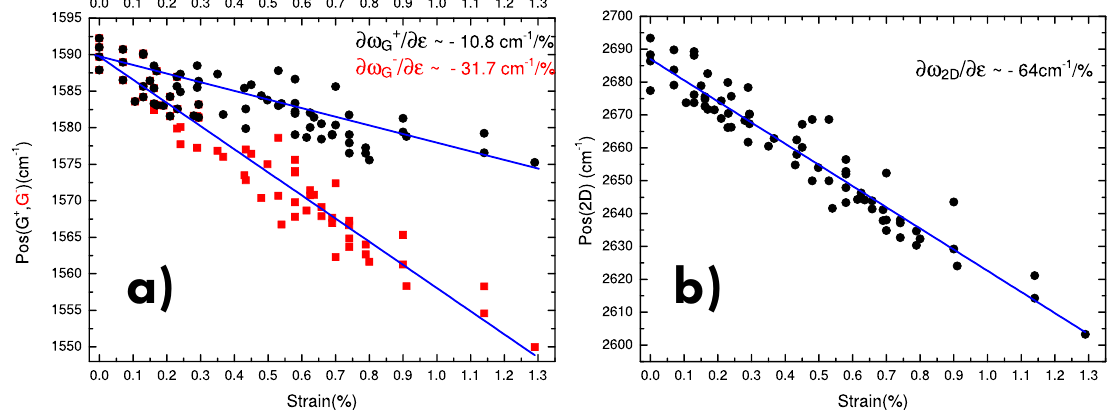
Figure 24. Modification of peak frequency of ( a ) G, and ( b ) 2D bands as effect of uniaxial strain. In the former panel, the splitting of G band in the two G + and G – bands can be observed. Reprinted with permission from Ref. [98]. Copyright (2009) American Physical